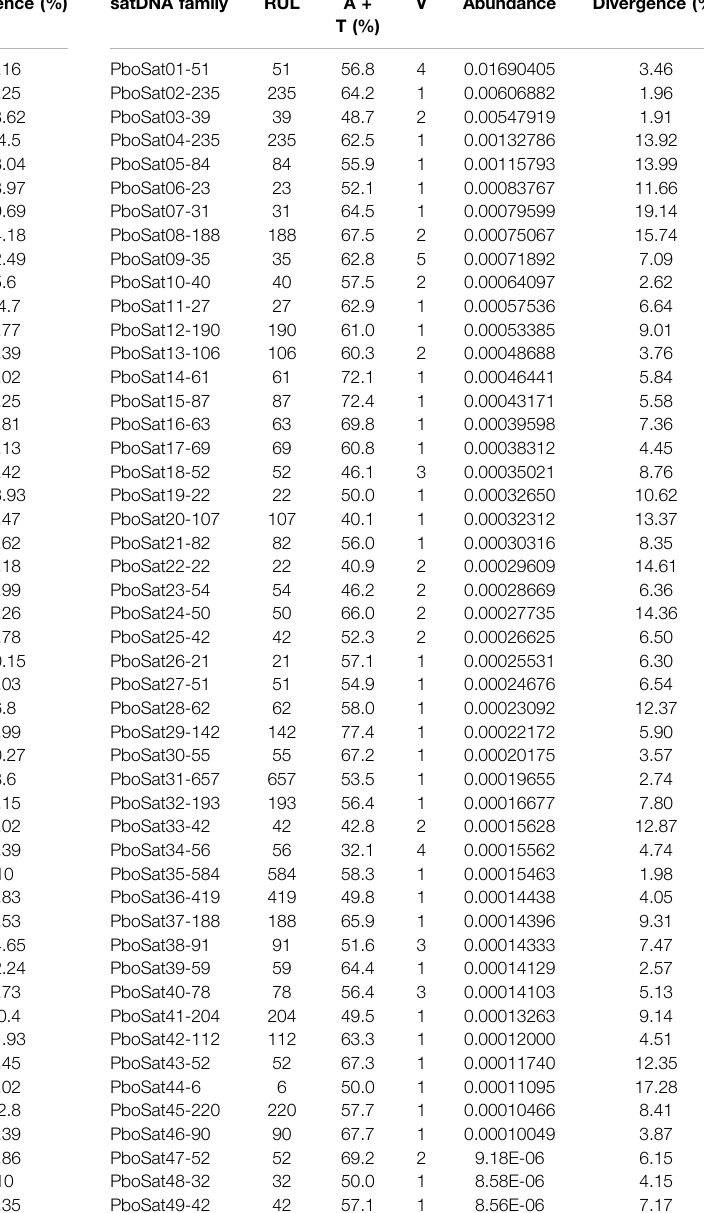
TABLE 1 | Main characteristics of Psalidodon fasciatus